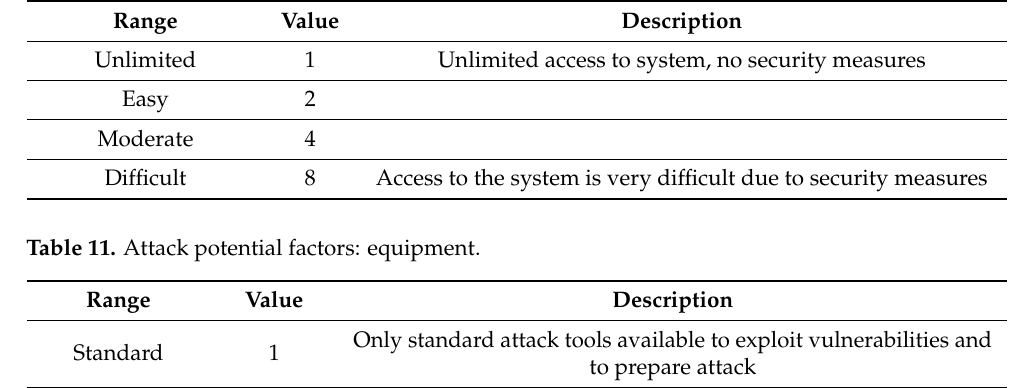
Table 10. Attack potential factor: access.